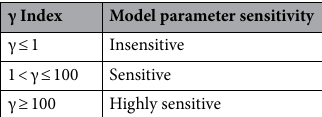
Table 11. The range of γ index to determine sensitivity of each parameter 95 .